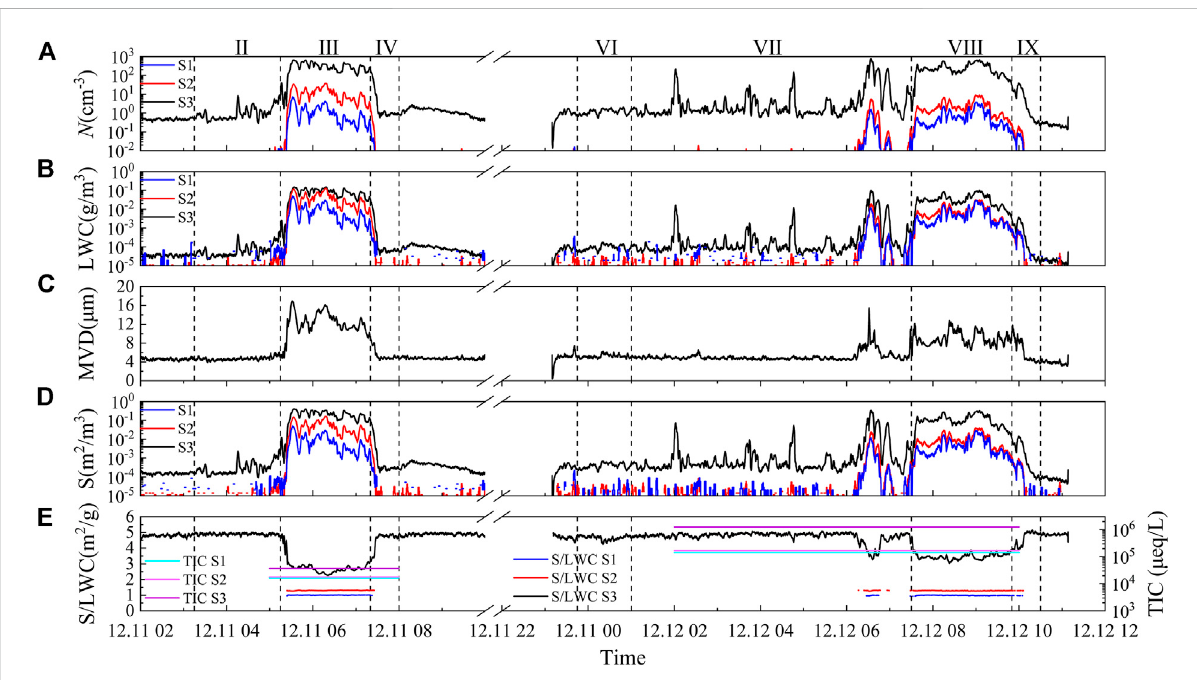
FIGURE 9 Time series of fog droplet (A) number concentration (N), (B) liquid-water content (LWC), (C) mean-volume diameter (MVD), (D) total surface area (S), and (E) ration of S to LWC (S/LWC) and total ion concentration (TIC) during the two persistent fog cases. The S1, S2, and S3 represent the sample for the large droplets of diameter larger than 22 μ m, medium droplets of diameter within 16 – 22 μ m, and small droplets of diameter within 4 – 16 μ m, respectively. II, III, and IV correspond to the formation, mature, and dissipation phase of the fi rst fog, respectively. VI VII, VIII, and IX correspond to the formation, development, mature, and dissipation phase of the second fog,